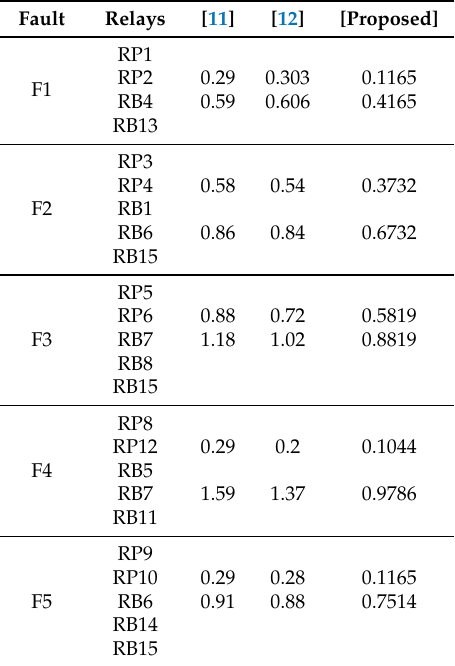
Table 4. Operation times for